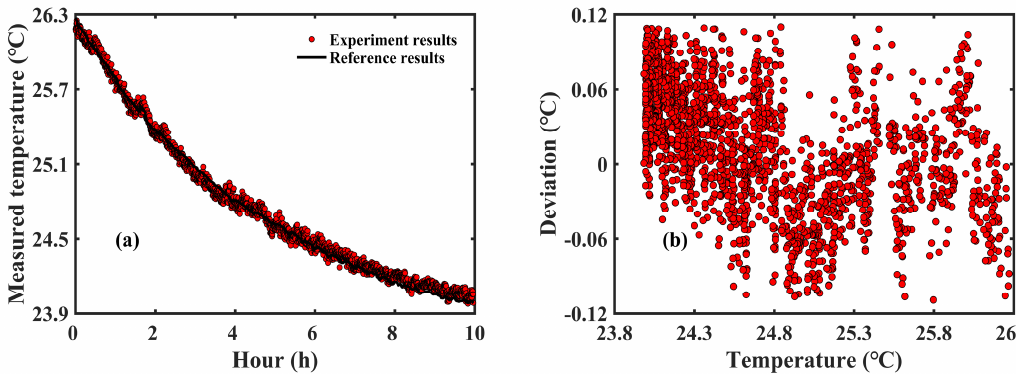
8 of 13 Figure 5. ( a ) Cross-correlation patterns in 25.33 °C; ( b ) cross-correlation patterns in 24.50 °C. Figure 6. ( a ) Results of the Hilbert transform in 25.33 °C; ( b ) results of the Hilbert transform in 24.50 °C. We conducted 10-h-long measurements from 10:00 p.m. to 8:00 a.m. and from 9:00 p.m. to 7:00 a.m., and the results are shown in Figures 7a and 8a. Please note that the data are stored in a short time interval in the former experiment, and the latter in a lager time interval. In Figures 7a and 8a,